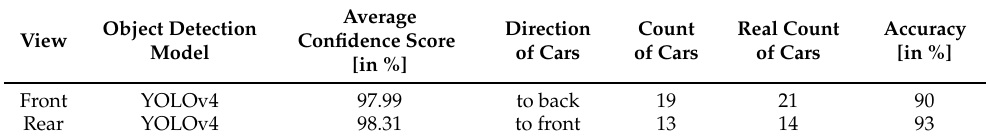
Table 4. Specific information of the Sample scenario #1.